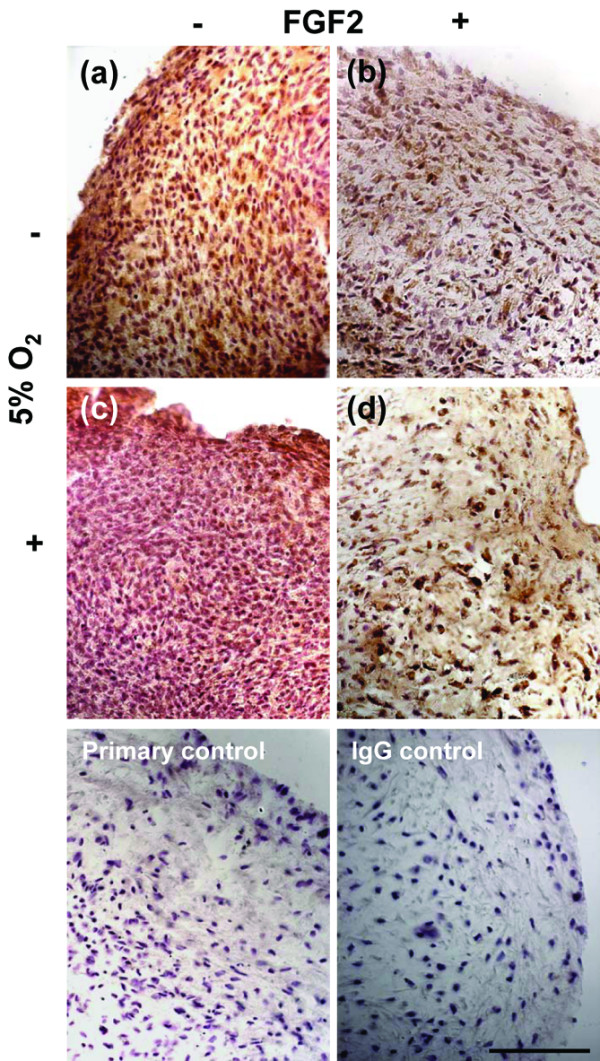
Immunolocalisation of type II collagen in cell aggregates after 14 days of culture. Cell aggregates derived from meniscus cells expanded in the absence ((a) normoxia; (c) hypoxia) and presence ((b) normoxia; (d) hypoxia) of fibroblast growth factor 2 (FGF2). No primary antibody control on cell aggregates derived from non-FGF2-expanded and FGF2-expanded cells after culture under hypoxia. Scale bar, 100 μm.